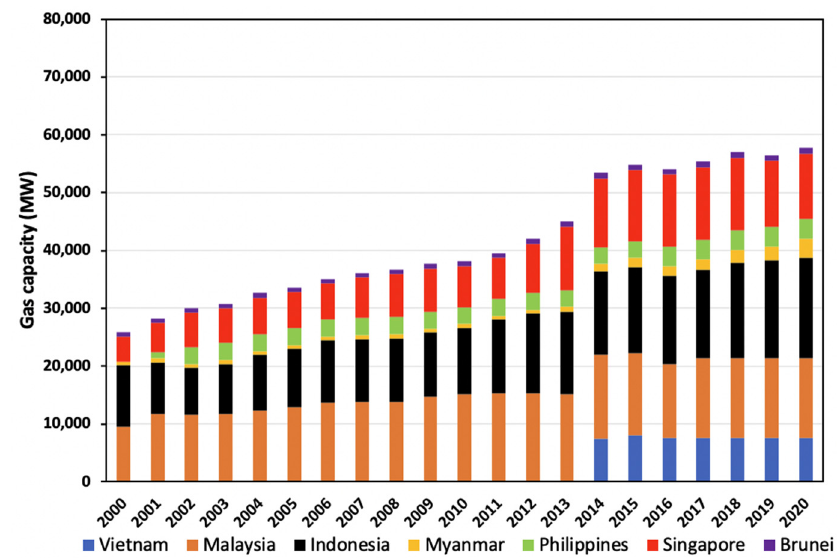
Figure 14. History of installed gas power capacity in ASEAN [22].